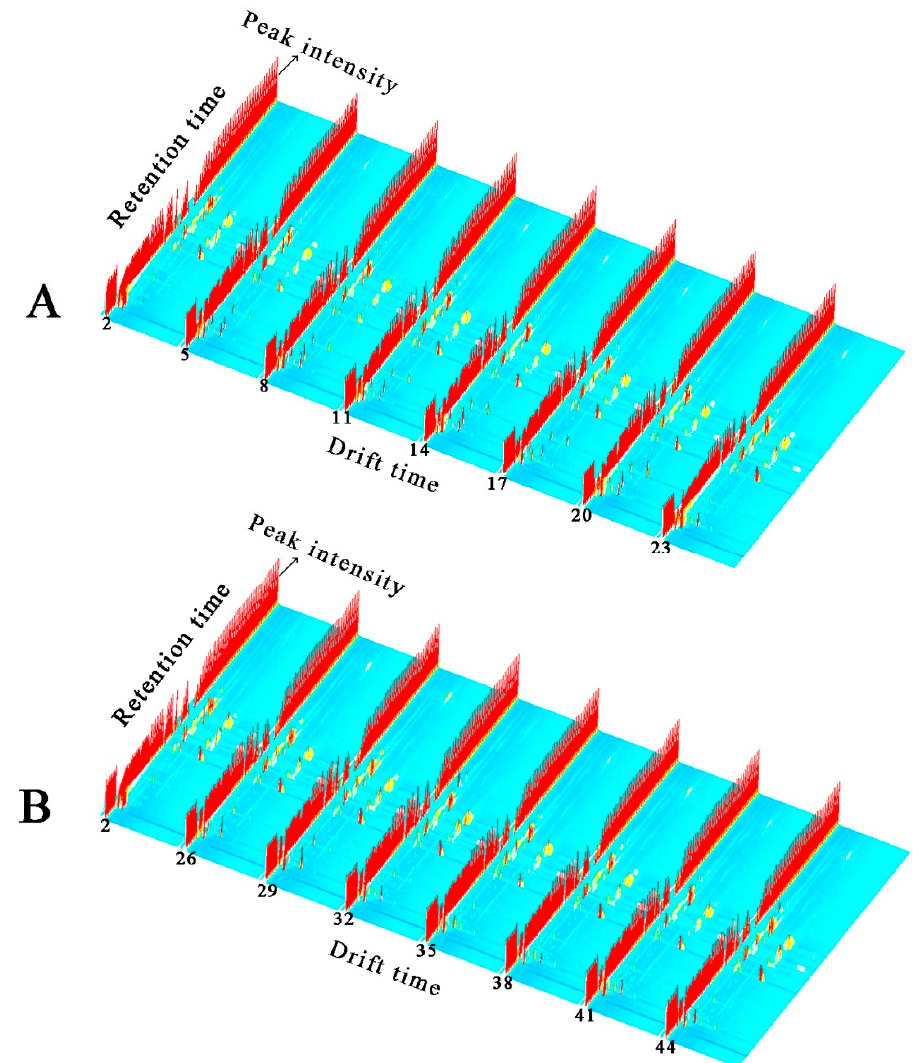
Figure 1. 3D topographic images of fresh kumquats (FKs) and vacuum osmosis with sugar and then hot air drying kumquats (VS-ADKs). 2: FKs; 5: kumquats with vacuum sugaring and then hot air drying for 0 h (VS-ADKs for 0 h); 8: VS-ADKs for 1 h; 11: VS-ADKs for 2 h; 14: VS-ADKs for 4 h; 17: VS-ADKs for 6 h; 20: VS-ADKs for 8 h; 23: VS-ADKs for 10 h; These are showed in figure 1A. 3D topographic images of fresh kumquats (FKs) and atmospheric pressure osmosis with sugar and then hot air drying kumquats (AS-ADKs). 2: FKs; 26: kumquats with atmospheric pressure sugaring and then hot air drying for 0 h (AS-ADKs for 0 h); 29: AS-ADKs for 1 h; 32: AS-ADKs for 2 h; 35: AS-ADKs for 4 h; 38: AS-ADKs for 6 h; 41: AS-ADKs for 8 h; and 44: AS-ADKs for 10 h; These are showed in figure 1B.